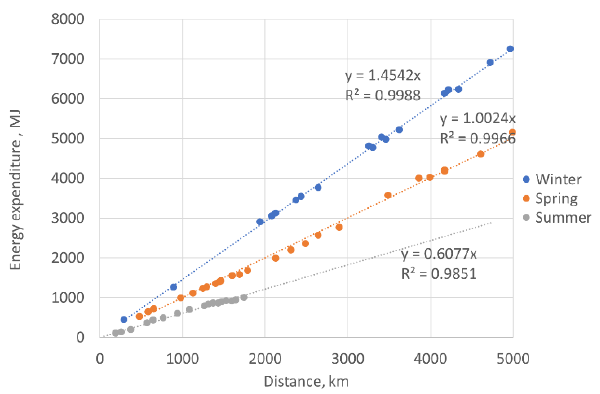
Fig. 4. The cumulative expenditure of converted energy (for a distance of approximately 50 km) in relation to the total vehicle mileage during the period considered